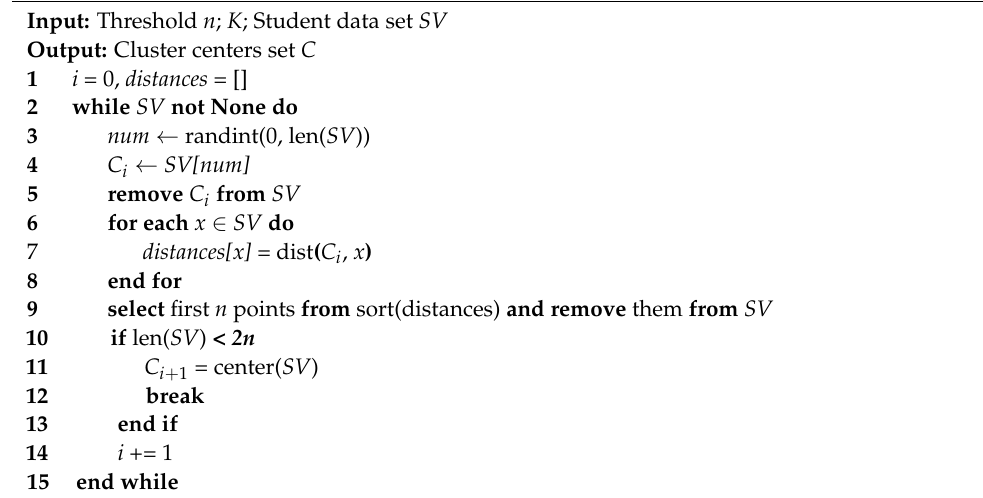
Algorithm 1 Improved initial cluster center selection